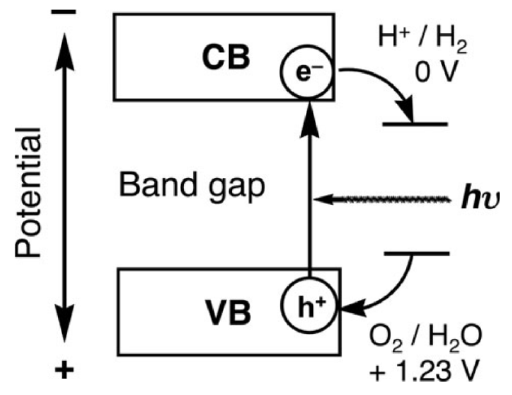
Figure 1. Mechanism of photocatalytic water splitting reproduced (“adapted” or “in